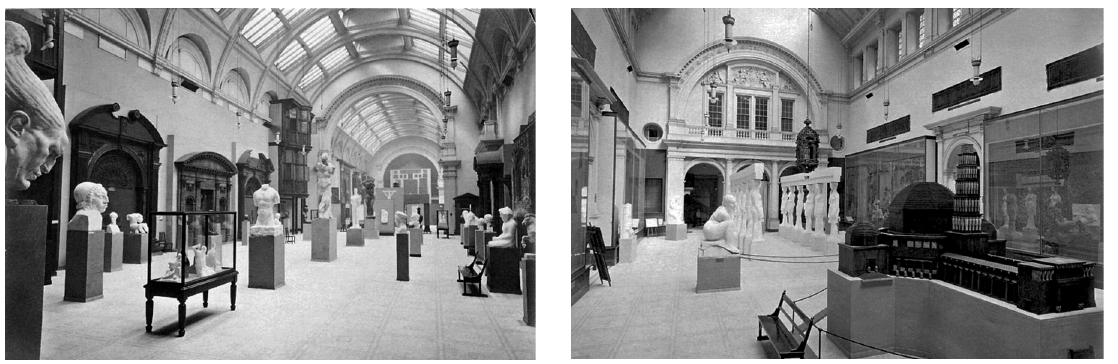
FIGUre 1+2 Meštrović exhibition at the Victoria & Albert Museum, London, 1915, from: